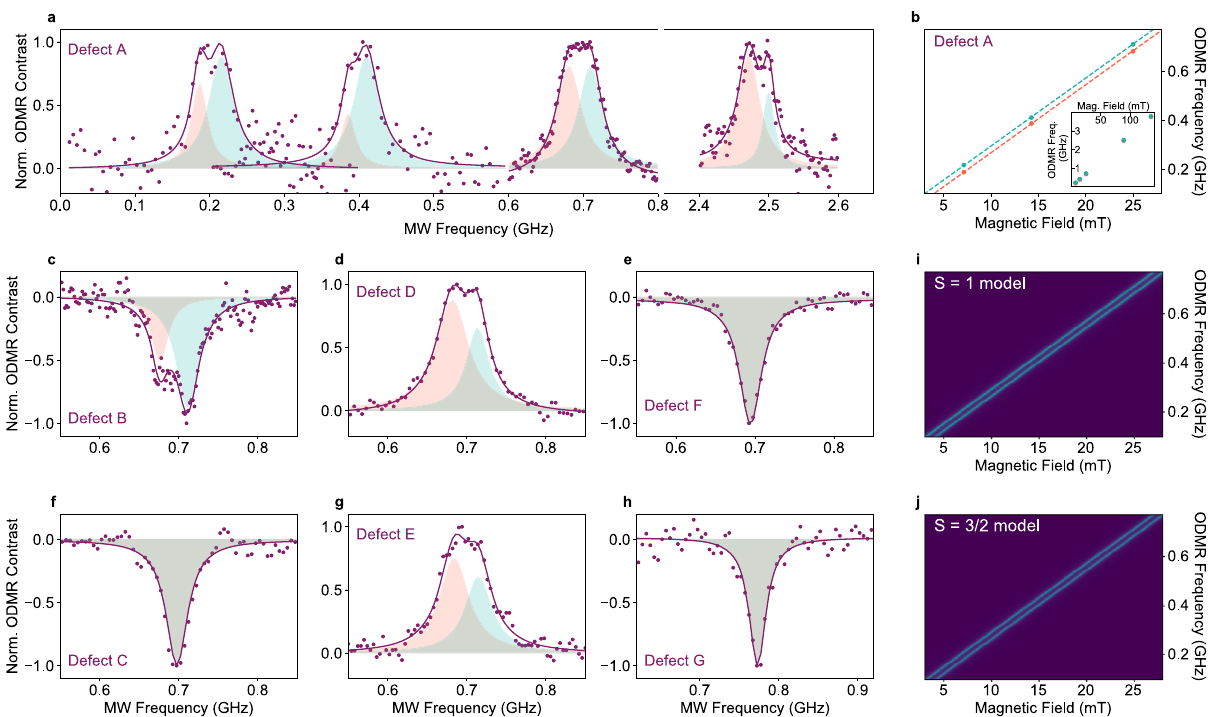
Fig. 4 Sub-linewidth structure and angle-dependence of below-saturation ODMR spectra. a Unsaturated ( P sat microwave and 1.2 P sat optical ) normalised ODMR spectra for defect A with double-Lorentzian fi ts at a range of magnetic- fi eld strengths. Coloured circles are the experimental results obtained at 7 mT, 14 mT, 25 mT and 89 mT, coloured solid curves are double-Lorentzian fi ts. For each panel, the shaded blue and red Lorentzian lineshapes show the two components of the doublet. b The ODMR frequency of each component of the double-Lorentzian fi t, as a function of magnetic fi eld. c – h Below- saturation normalised ODMR spectra for defects B, C, D, E, F and G obtained at 25 mT with a fi xed in-plane magnet position. Shaded regions indicate the two components of the doublet Lorentzian fi ts. ( i ) ODMR simulation for S = 1 system with D = 14 MHz and E = 4 MHz ( j ) ODMR simulation for S ¼ 3 system with D = 7 MHz and E = 2 MHz. In both ( i ) and ( j ) the magnetic fi eld applied along the lab frame axis z and the defects symmetry axis (principal axis of defect ’ s D tensor) z ′ . The signal intensity is normalised to 1 and represented by the blue shaded